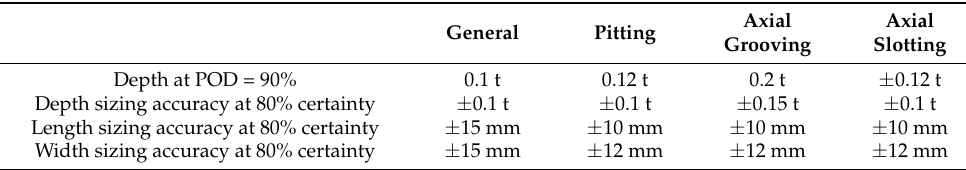
Figure 1. Principles of magnetic flux leakage in-line inspection. Table 1. Inspection accuracy of axial magnetic flux leakage tool.